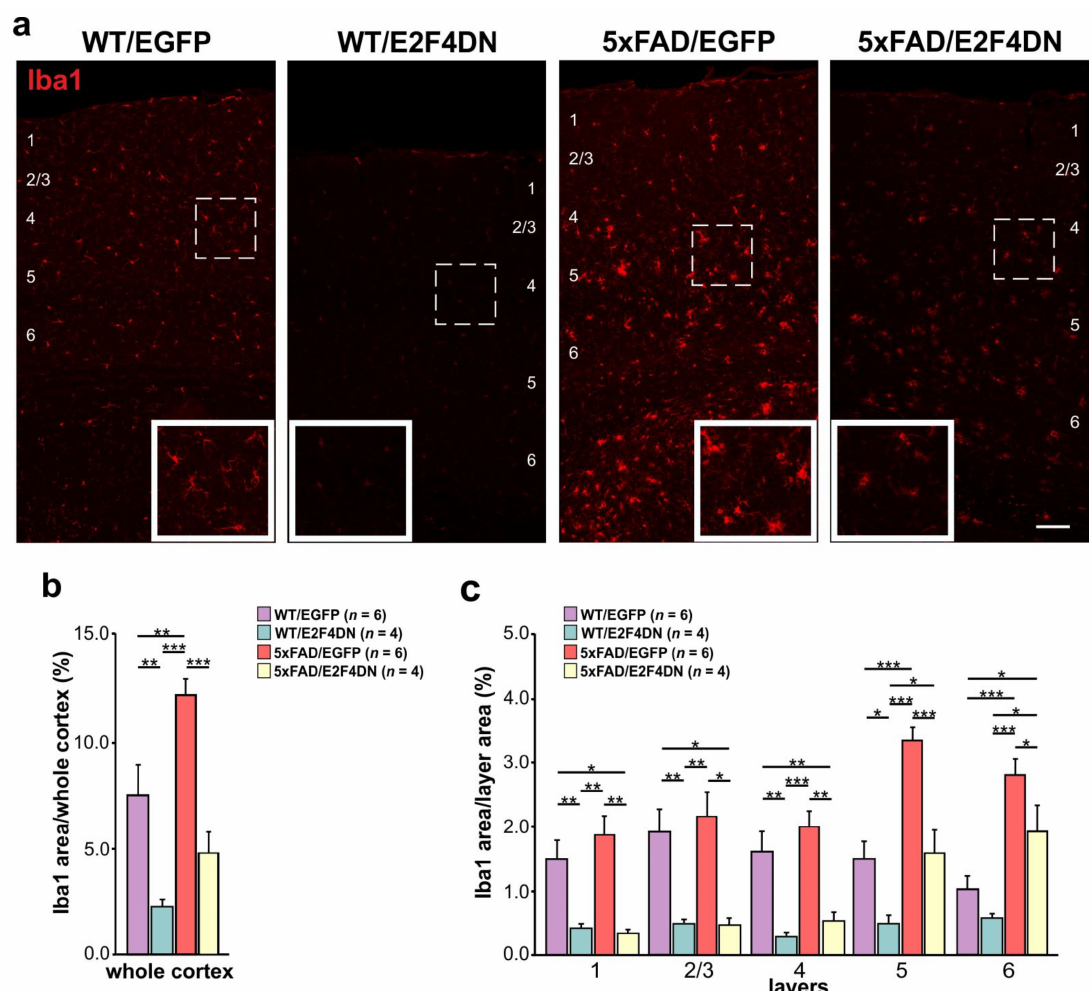
Figure 3. Modulation of microgliosis by E2F4DN in the cerebral cortex of 1-year-old 5xFAD mice. ( a ) Iba1 immunostaining in the cerebral cortex of mice of the indicated genotypes at 1 year. Numbers refer to the different cortical layers (identified by DAPI staining; not shown). Inserts show the high magnifications of the indicated dashed boxes. ( b ) Percentage of the area occupied by Iba1 immunostaining in the cerebral cortex of mice of the indicated genotypes at 1 year. ( c ) Percentages of the area occupied by Iba1 immunostaining in the indicated cortical layers at 1 year. * p < 0.05; ** p < 0.01; *** p < 0.001 (one-way ANOVA followed by post hoc Newman-Keuls test). Scale bar: 100 µ